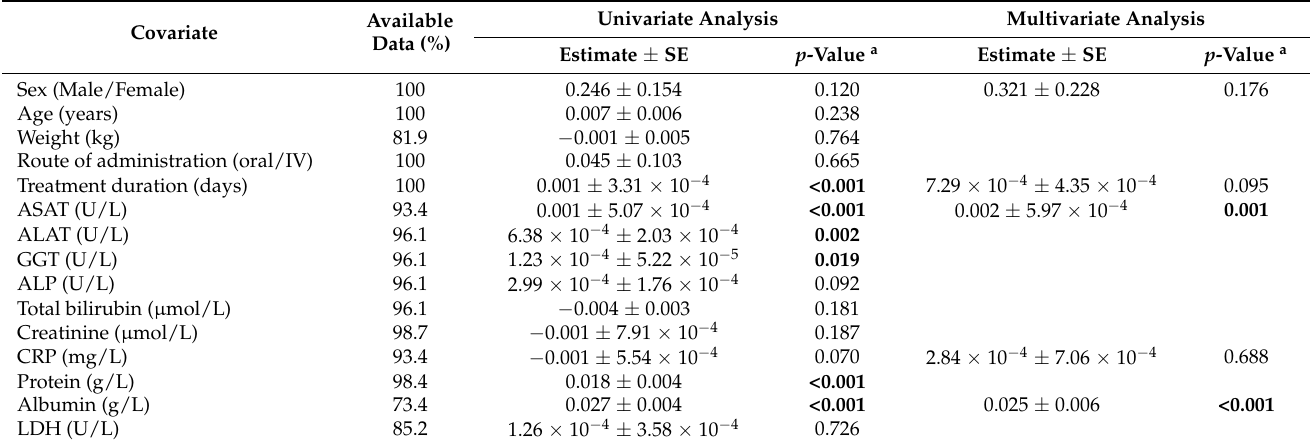
Table 3. Factors that contribute to the variability of ISA Cmin after weighting by daily dose.